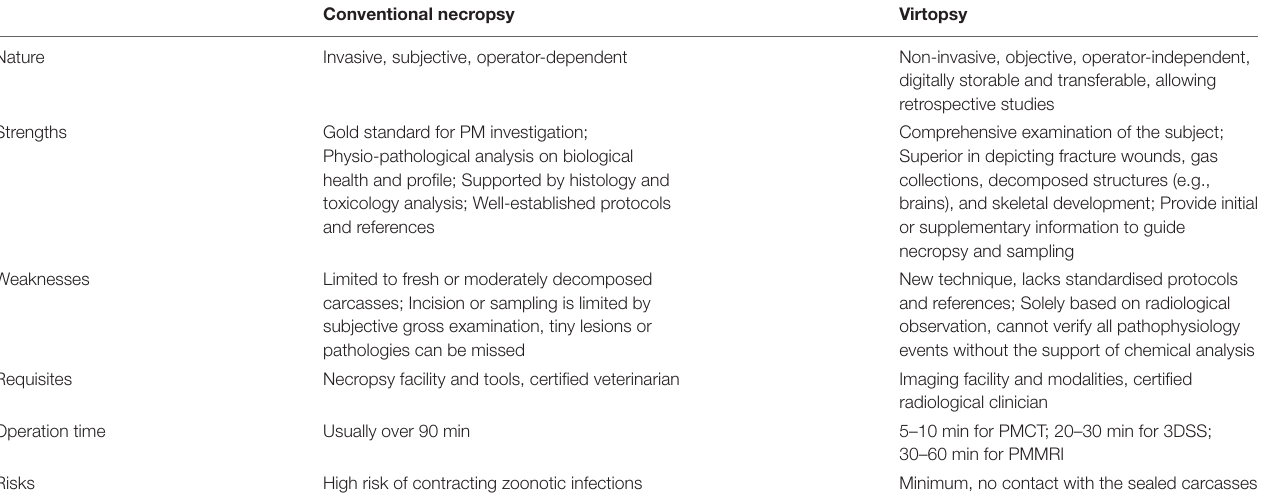
TABLE 1 | Summary of the advantages and disadvantages of virtopsy compared to conventional